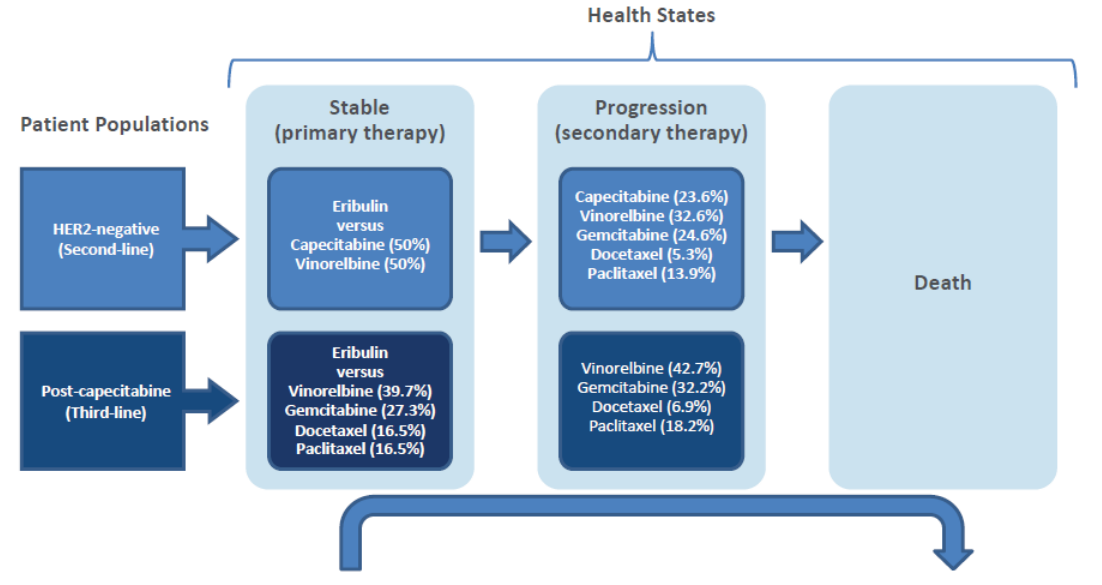
HER2: human epidermal growth factor receptor